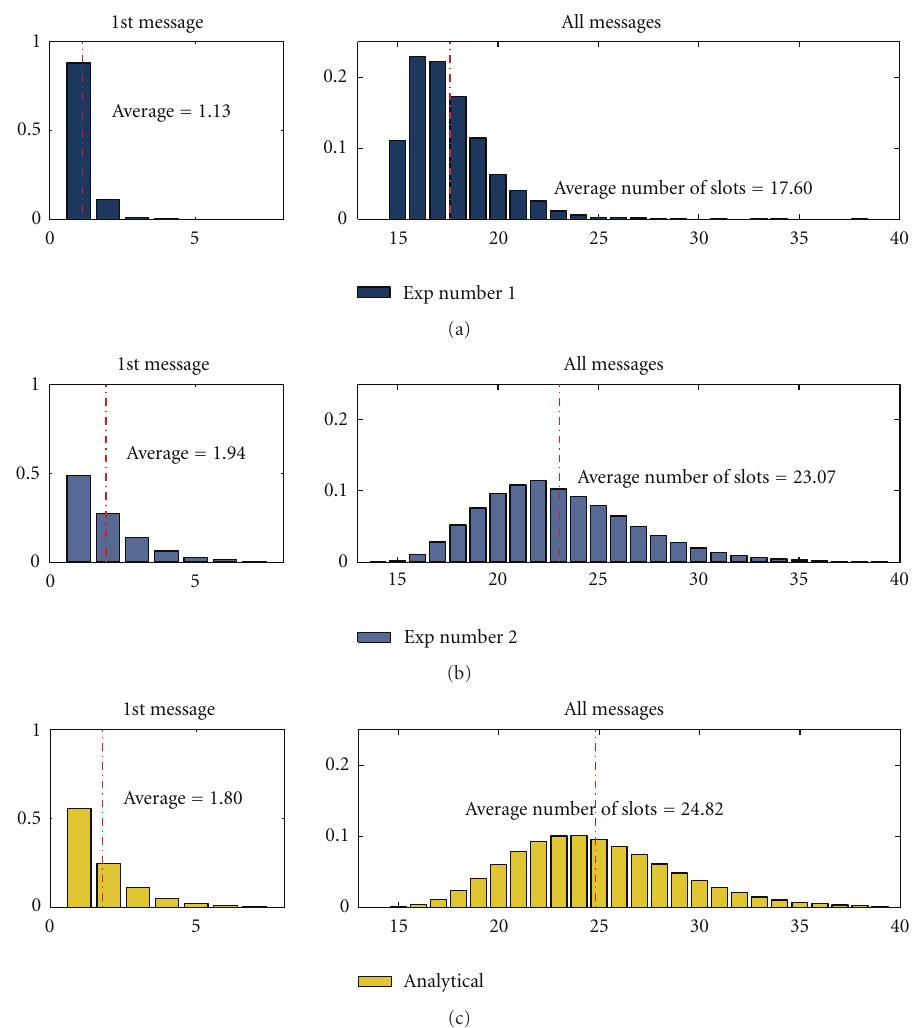
Figure 10: Experiment results: measured distribution of number of time slots needed to send the first message (left) and all messages (right) for experiment setup number 1 (a) and number 2 (b) and comparison with analytical results